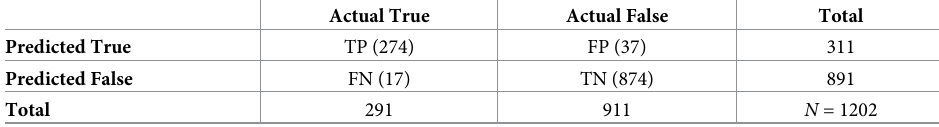
Table 10. Confusion matrix for Co-training semi-supervised algorithm on the test